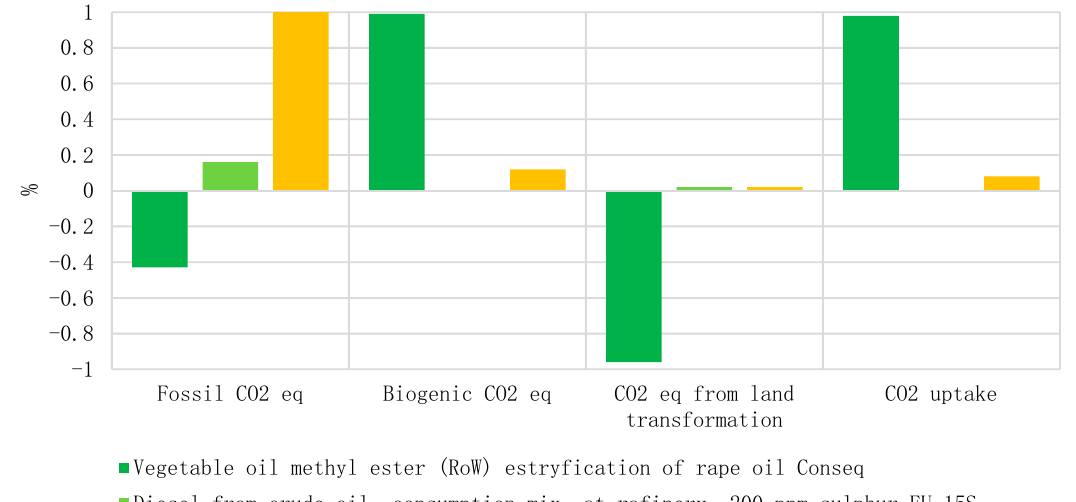
-0.200.20.40.60.811.21.41.61.82 1 -butanol (RER) hydroformylation of propylene Conseq S